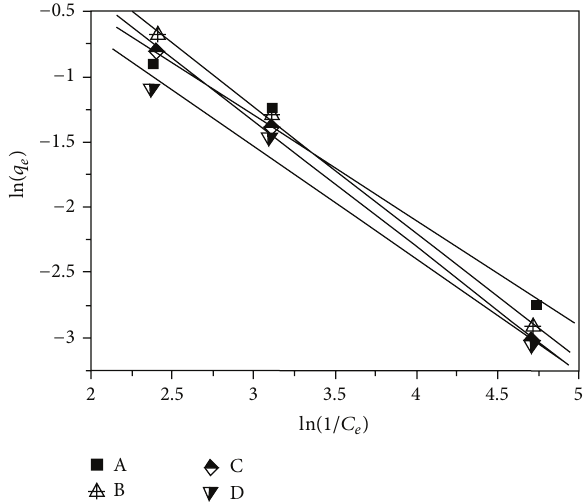
Figure 5: Plot of the Temkin isotherm model for lead(II) adsorption on samples A–D.